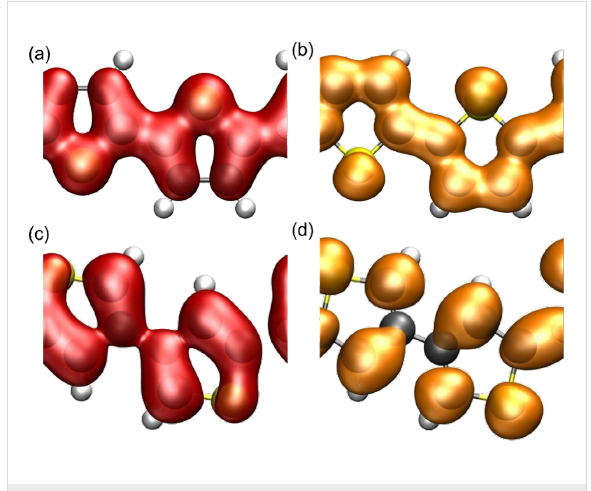
Figure 3: Electronic density isosurfaces ( ρ ( r ) = 0 . 01 e/ Å 3 ) of the highest occupied crystal orbital (HOCO, red) and the lowest unoccu- pied crystal orbital (LUCO, orange) for PTp (a,b) and α , β -PTp